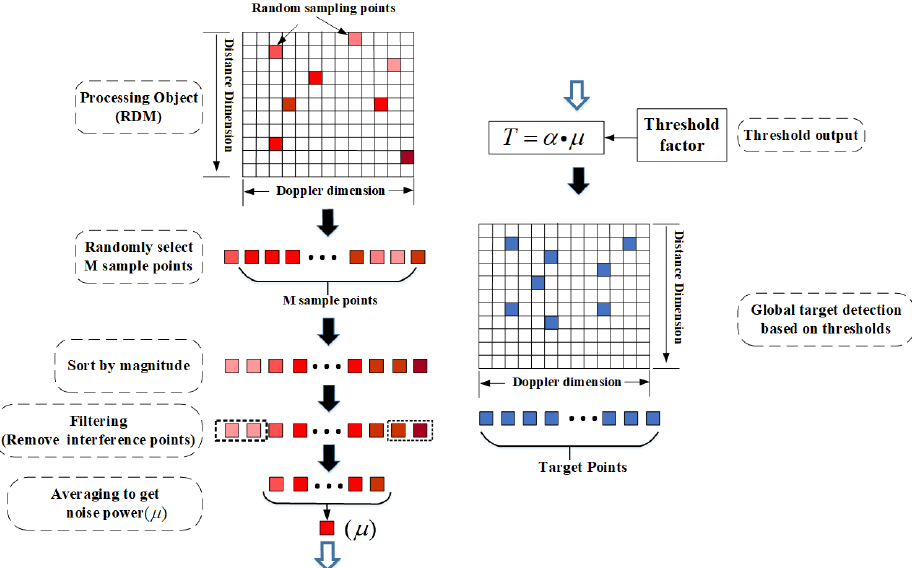
Figure 10. MC-CFAR processing